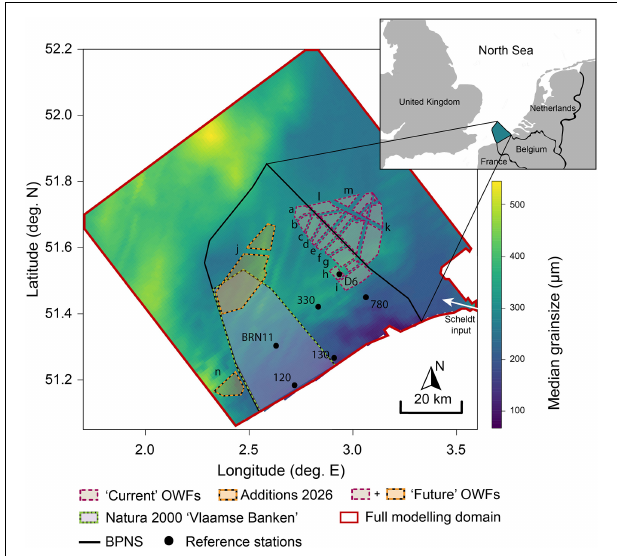
FIGURE 1 | Median grain size ( µ m) of sediments in the modeled domain, with the Belgian Part of the North Sea (BPNS) delineated in black. Current OWF developments (2021) outlined in purple, and future developments (operational ± 2026) in orange, with letters corresponding to concession zone characteristics in Table 3 . Black dots correspond to stations sampled for sediment biogeochemistry by Toussaint et al. (2021), used as reference